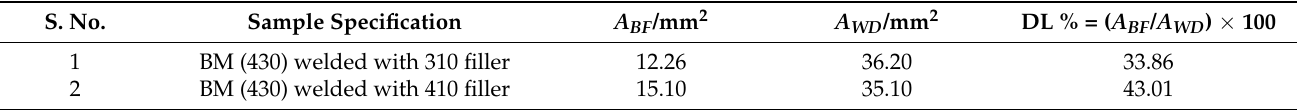
Table 3. Dilution for different fillers in welding.